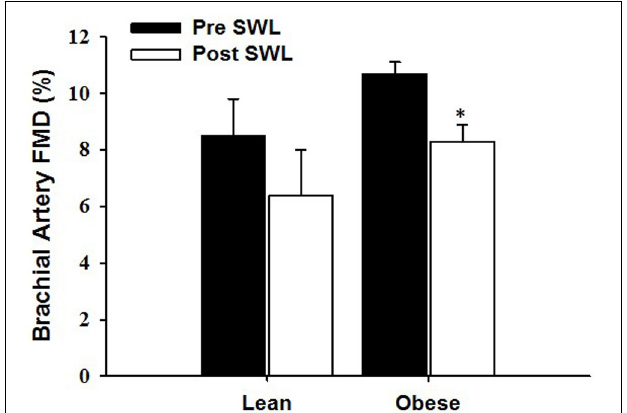
FIGURE 2 | The effect of a single bout of strenuous weight lifting (SWL) on brachial artery flow-mediated dilation (FMD) in lean (LN) and obese (OB) sedentary women. ∗ Significant difference observed after SWL vs. before SWL ( p < 0 . 05).